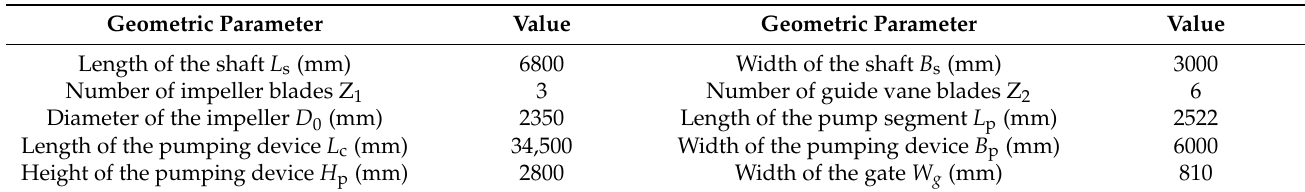
Figure 2. The vertical shaft tubular pumping device model. ( a ) Longitudinal section; ( b ) Horizon- Figure 2. Theverticalshafttubularpumpingdevicemodel. ( a )Longitudinalsection; ( b )Horizontalsection. tal section. Table 1. Basic geometric parameters of the pumping Table 1. Basic geometric parameters of the pumping device.